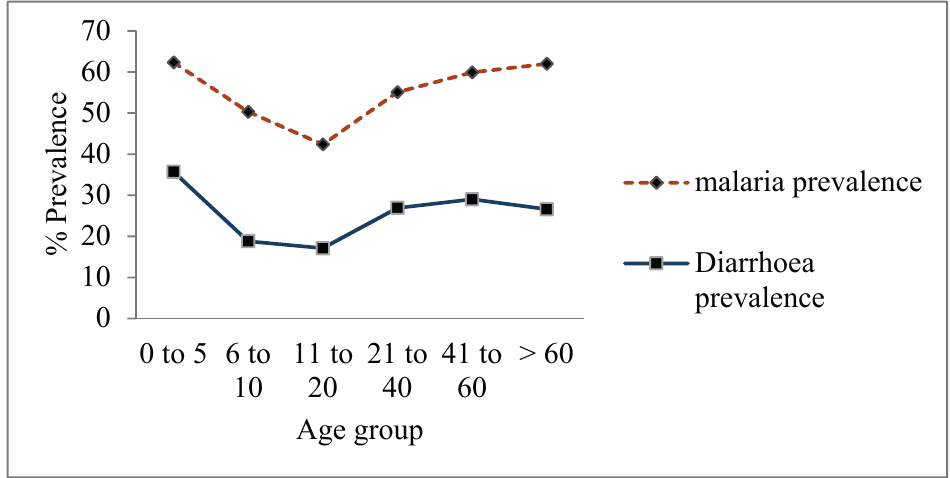
Figure 1. Curves showing the relationship between malaria and diarrheal illnesses with respect to age